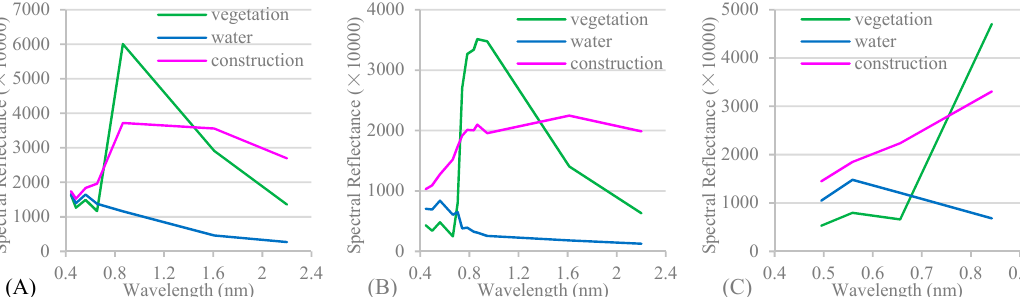
Figure A1. The spectral reflectance of vegetation, water and construction (construction land, mudflat and bare land) in ( A ). Landsat 8, ( B ). Sentinel-2 and ( C ). Pléiades-1 in level 1, which was produced based on 50 representative samples per class.